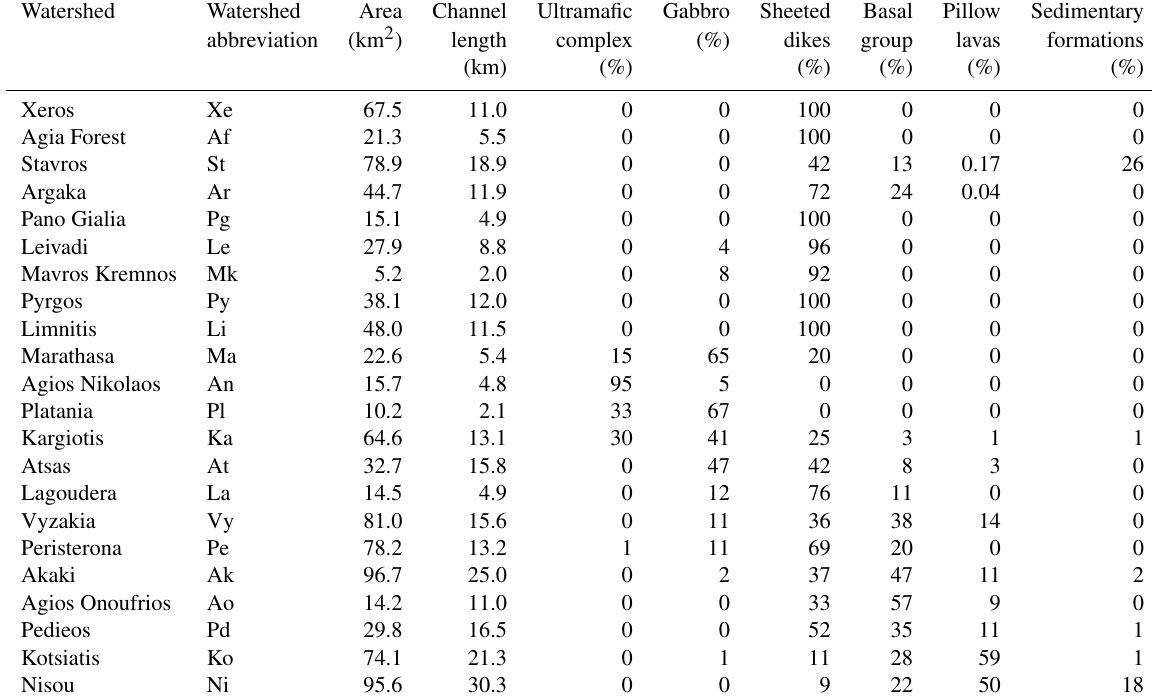
Table 1. Morphological and geological characteristics of the studied watersheds. Watershed